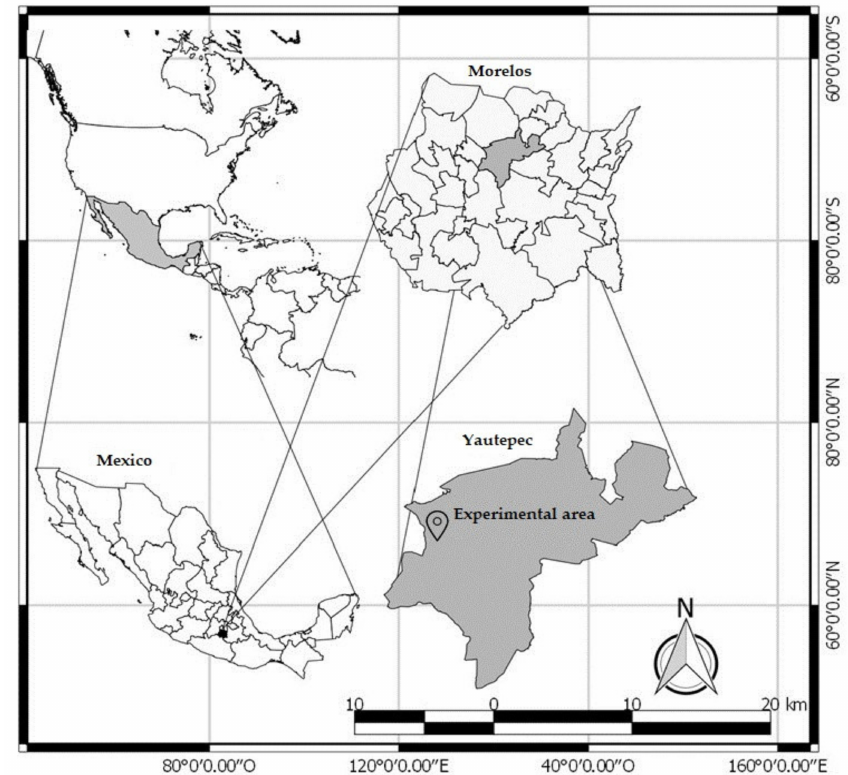
Figure 1. Location of the study area, Municipality of Yautepec, Morelos, Mexico.